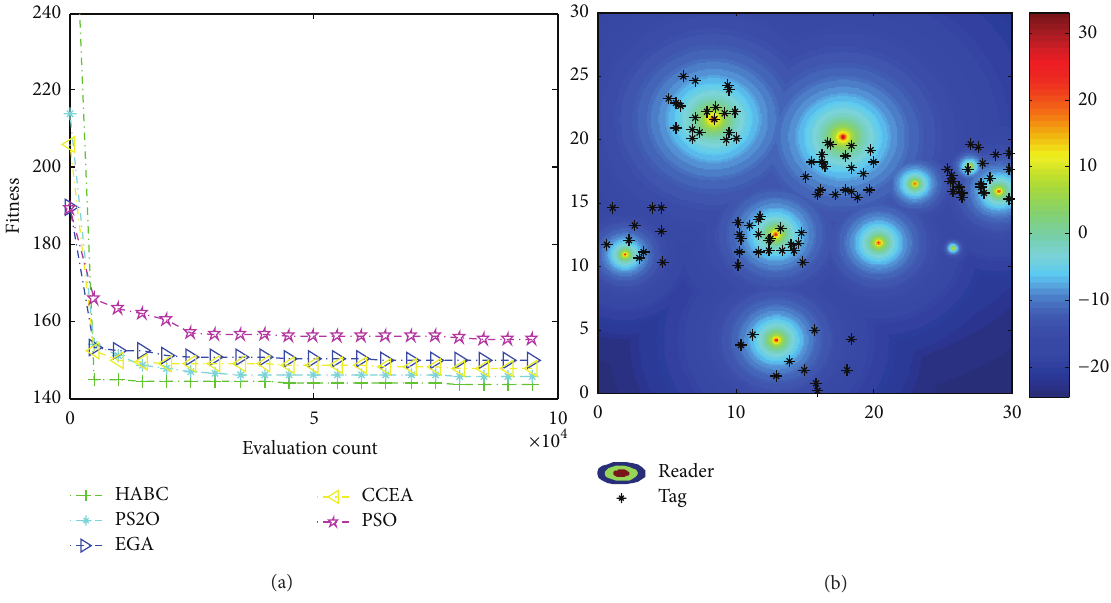
Figure 10: Results only consider interference. (a) Convergence process; (b) reader location and received power distribution.